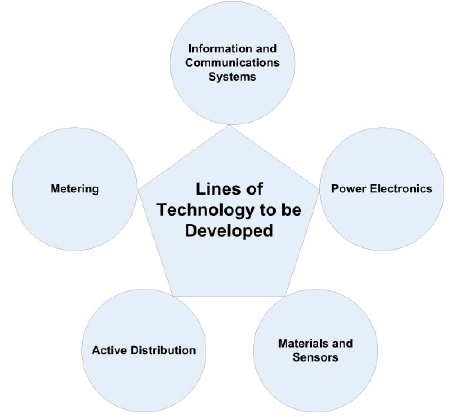
Figure 2. Technology to be developed for research areas of SGs.